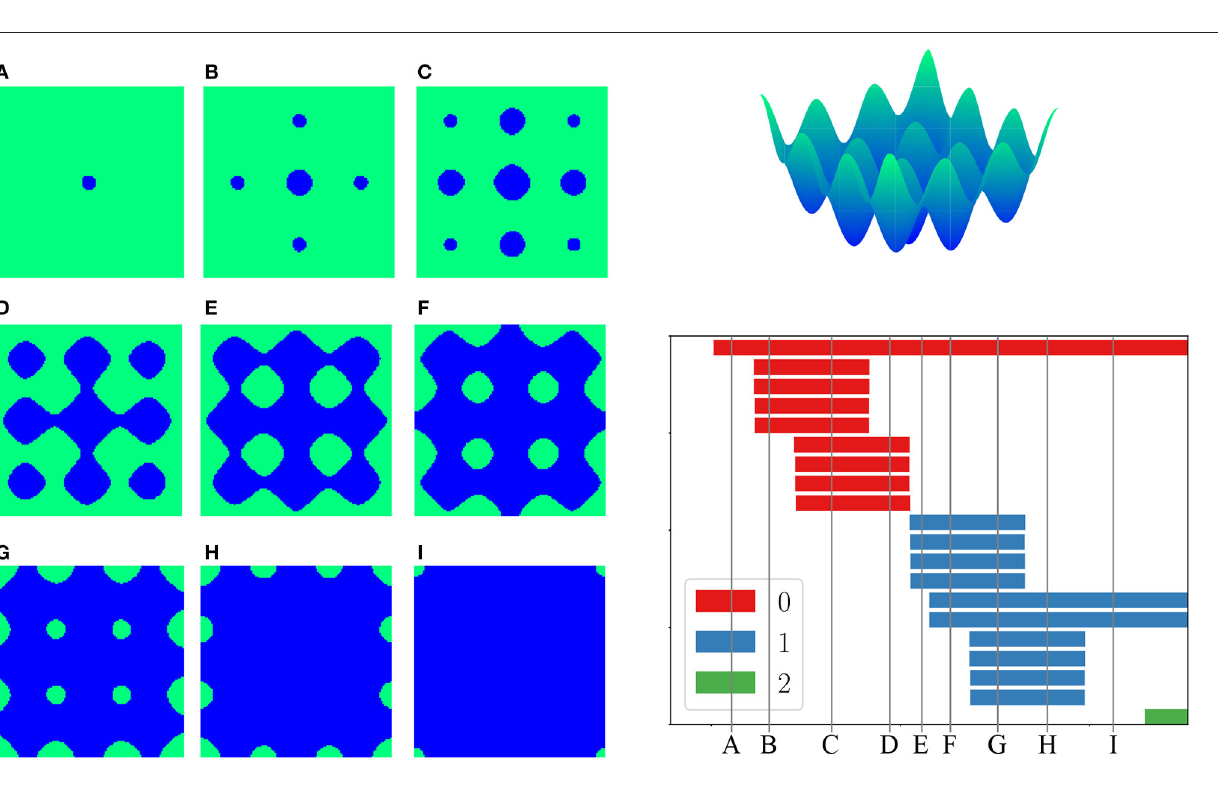
FIGURE 2 | (Top right) An energy function for the molecule pentane. The domain is a torus, i.e., a square with periodic boundary conditions, as there are two circular degrees of freedom (dihedral angles) in the molecule. (Left) Nine different sublevel sets of energy. (Bottom right) The sublevel set persistent homology of this energy function on the torus, with 0-dimensional homology in red, 1-dimensional homology in blue, 2-dimensional homology in green. Image from Mirth et al. (2021).